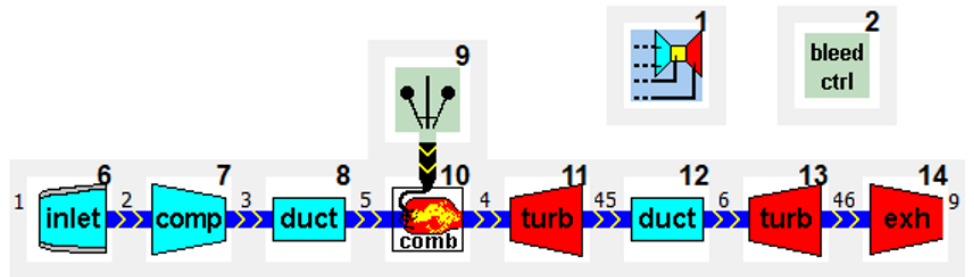
Figure 1. Model of the turboshaft in the GSP.